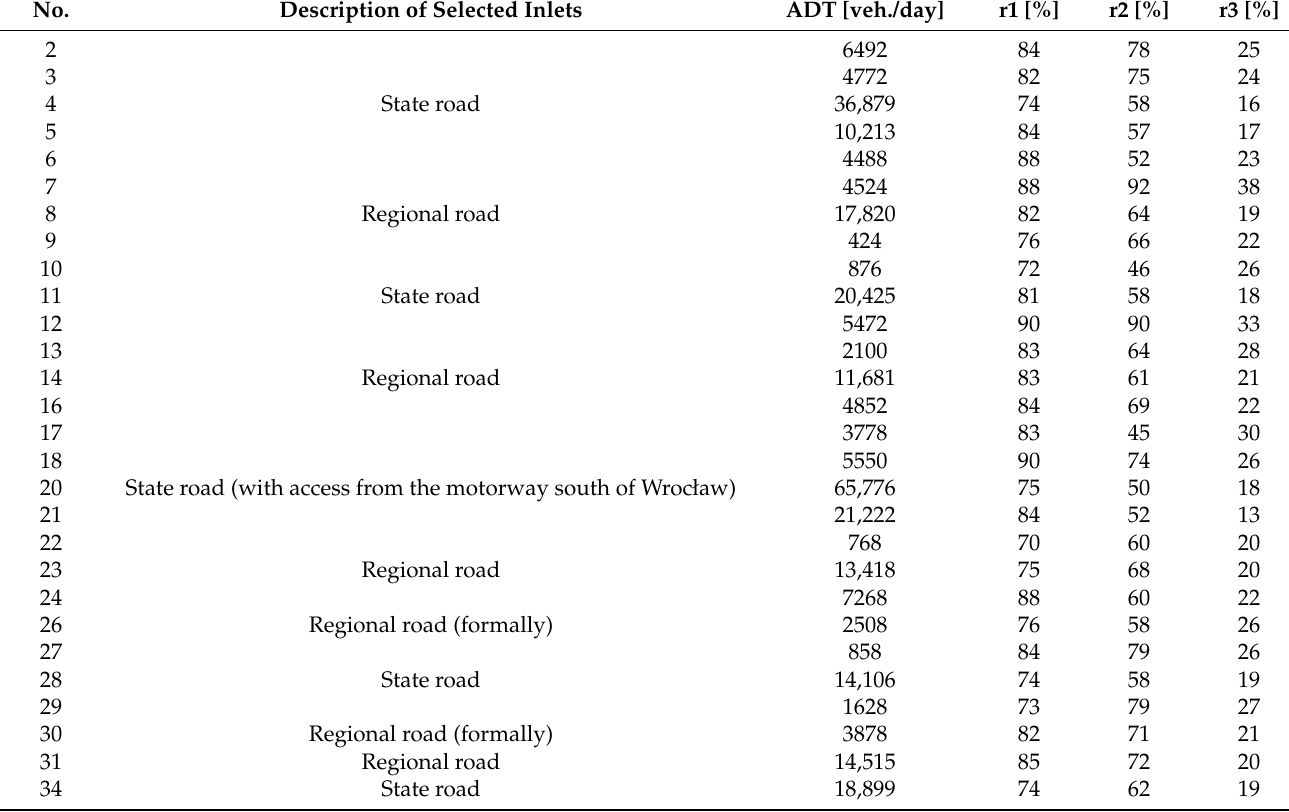
Table 3. Characteristics of inlets from surveys in the year